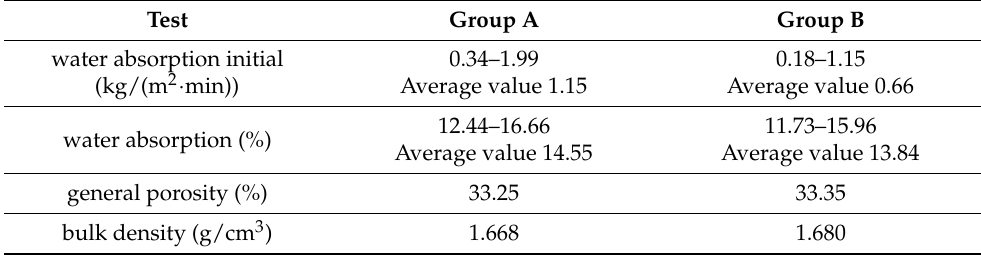
Table 6. Summary of test sample